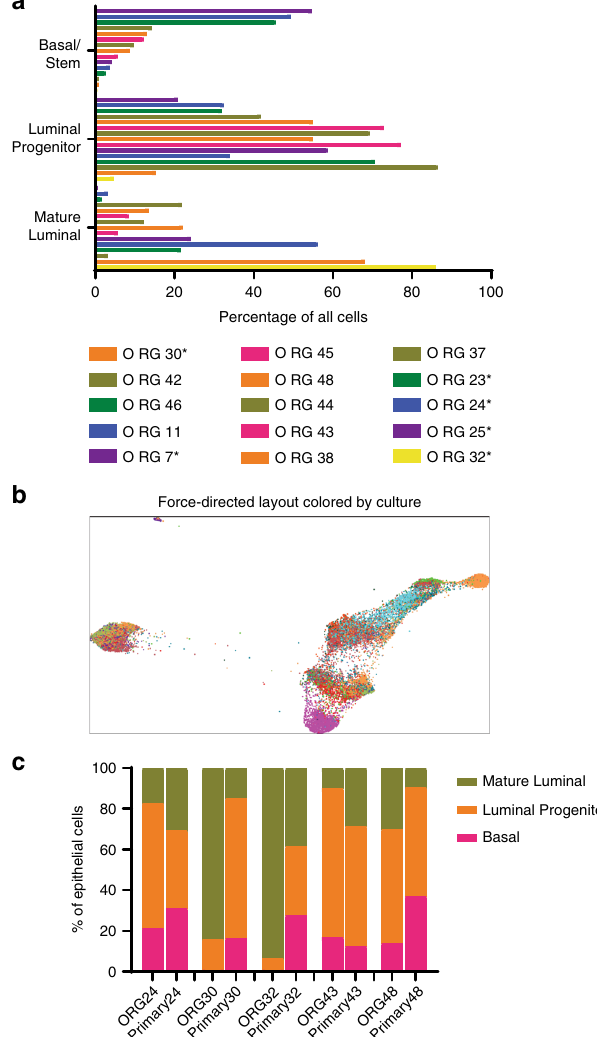
Fig. 6 Heterogeneity is present in the distribution of mammary lineages in organoid cultures. a The proportion of cells in the basal, luminal progenitor, and mature luminal lineages were determined using EpCAM and CD49f levels, as measured by CyTOF for each of the indicated 15 mammary organoid cultures. Samples without a known mutation in a breast cancer predisposition gene are indicated with an asterisk. All cases were normal by histology. b Force-directed layout in which each dot represents one cell that is colored by culture ID (see Supplementary Fig. 9). c Percentage of epithelial cells in each of the indicated major mammary lineages is shown for the indicated organoid cultures and matching primary